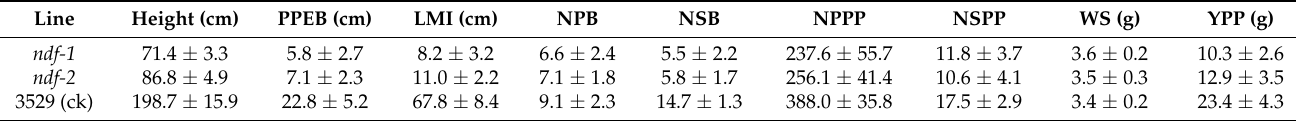
Table 1. Principal agronomic characteristics of two dwarf